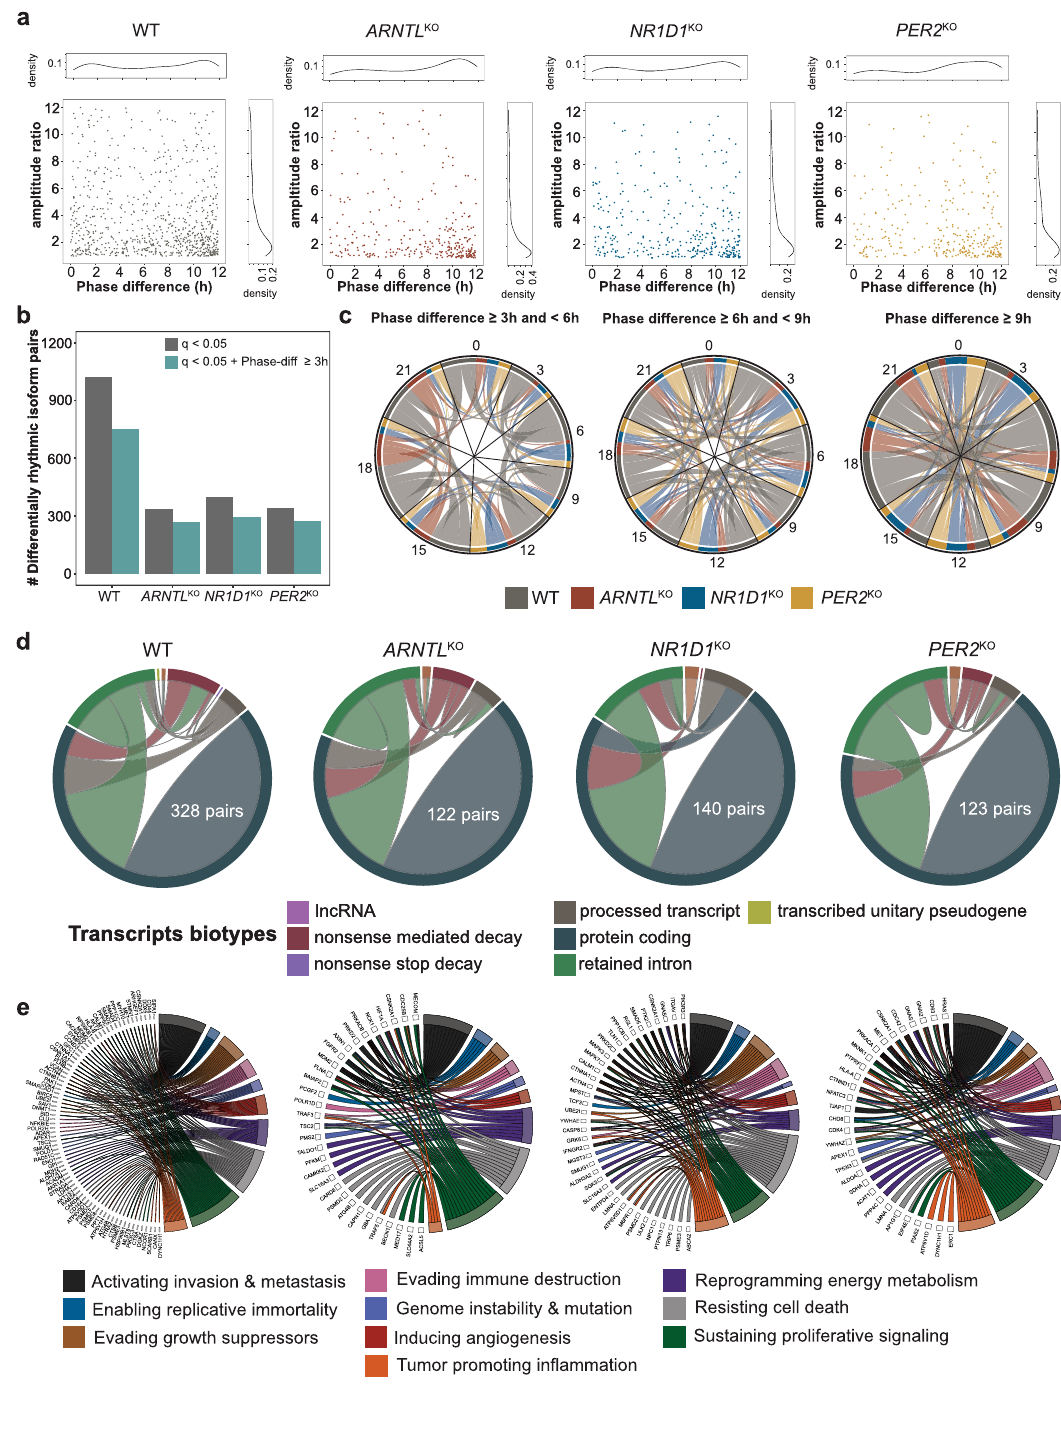
Fig. 5 Phase-shifted spliced isoforms in HCT116 datasets are associated with hallmarks of cancer. Differential rhythmicity analysis between rhythmic transcripts within the same cell line was carried out using DODR. a The scatter plot depicts the distribution of differentially rhythmic transcript pairs according to their phase difference and amplitude ratio in HCT116. b Decline in differentially rhythmic isoform pairs observed in all HCT116 KO . c The chord diagram represents the peak phases of transcript pairs across HCT116 under different phase shift cut-offs. d The chord diagram depicts the biotypes of phase shifted transcript pairs. e The circular plot shows the association of genes containing phase shifted transcript pairs with hallmarks of